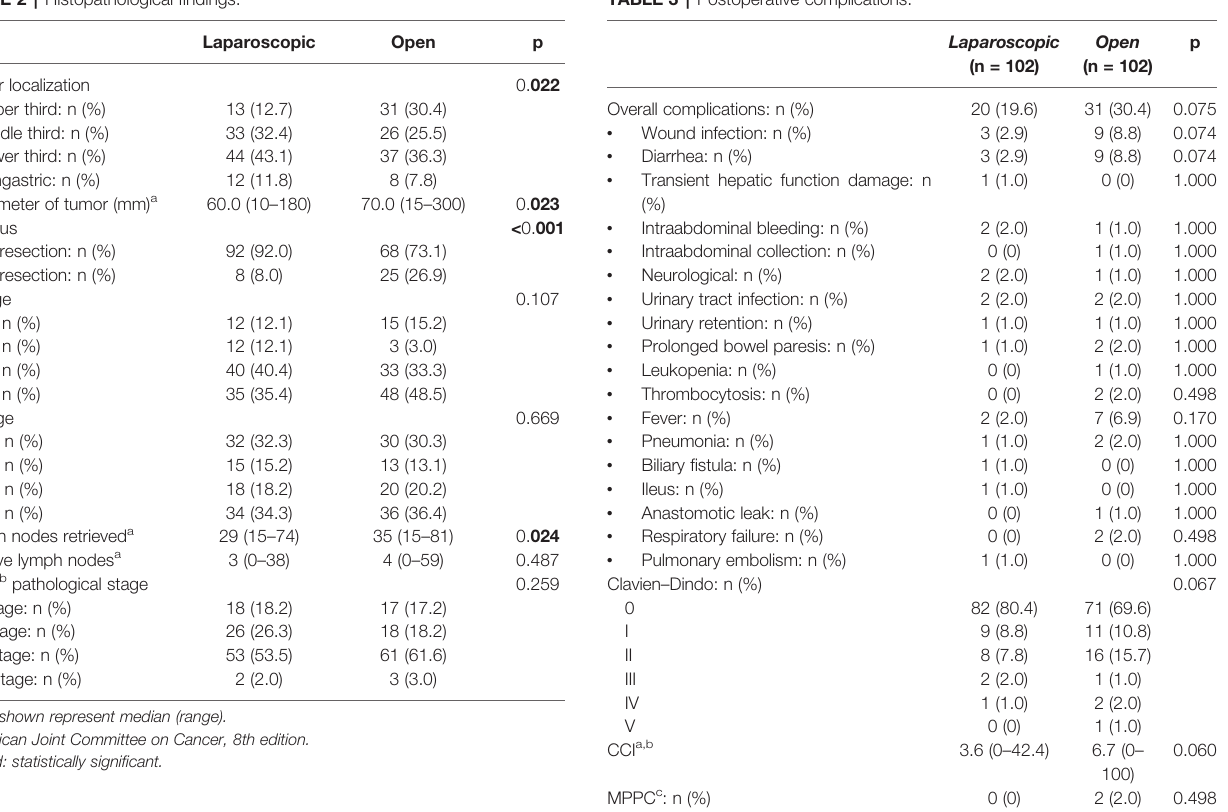
TABLE 3 | Postoperative complications.